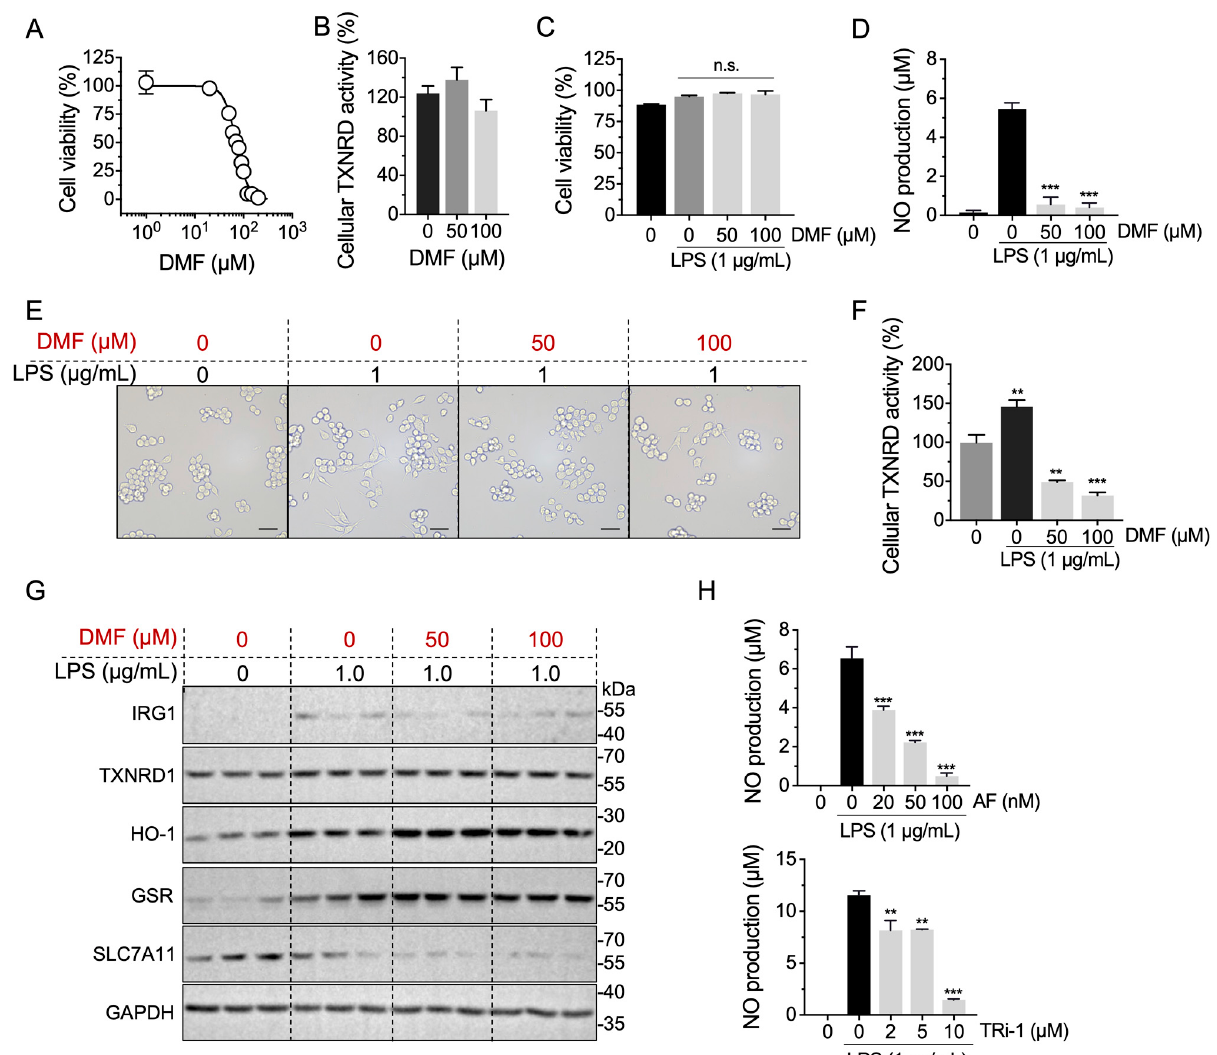
Figure 6. The anti-inflammation effect of DMF is correlated with TXNRD1. ( A ) DMF shows cytotoxic- ity to RAW 264.7 cells. After DMF treatment for 24 h, MTT assay was used to measure the cell viability of RAW 264.7 cells. ( B ) DMF does not affect cellular TXNRD1 activity in RAW 264.7 cells. Cellular TXNRD activity was determined upon DMF treatment for 6 h. ( C ) DMF presents no significant cytotoxicity to LPS-stimulated RAW 264.7 cells. Cells were treated with 1 µ g/mL LPS for 3 h, then the medium was discarded and cells were treated with DMF for additional 24 h, and the cell viability was measured by MTT assay. ( D ) DMF decreases the NO production of RAW 264.7 cells. Cells was treated with LPS for 3 h and then treated with DMF for 24 h in the absence of LPS. ( E ) Cellular morphology image of RAW 264.7 cells upon LPS treatment for 3 h and DMF for additional 3 h; scale bar represents 200 µ m. ( F ) DMF inhibits cellular TXNRD activity in combination with LPS treatment. RAW 264.7 cells were stimulated with 1 µ g/mL LPS for 3 h, and then cells were treated with indicated concentrations of DMF in the absence of LPS for 3 h. ( G ) Western blot of NRF2-targrt genes. RAW 264.7 cells were stimulated with 1 µ g/mL LPS for 3 h, and then cells were treated with the indicated concentrations of DMF in the absence of LPS for 3 h. ( H ) NO production in RAW 264.7 cells upon auranofin or TRi-1 treatment, combined with LPS stimulation. RAW 264.7 cells were stimulated with 1 µ g/mL LPS for 3 h and then treated with auranofin (upper panel) or TRi-1 (lower panel) for 24 h in the absence of LPS and the NO production was assayed. **, p < 0.01, ***, p < 0.001, n.s., not significant. Taken together, our results showed that DMF inhibits TXNRD1’s activity by modifying the Sec and Cys residues in the catalytic motif of TXNRD1. In LPS-stimulated RAW